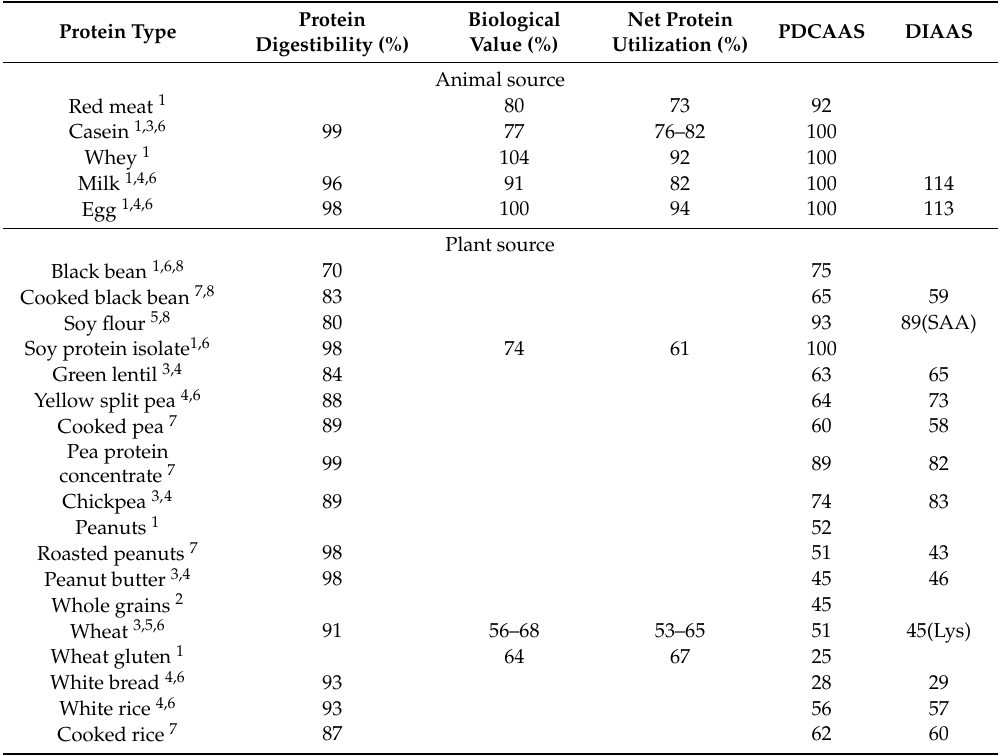
Table 1. Protein quality assessment based on protein